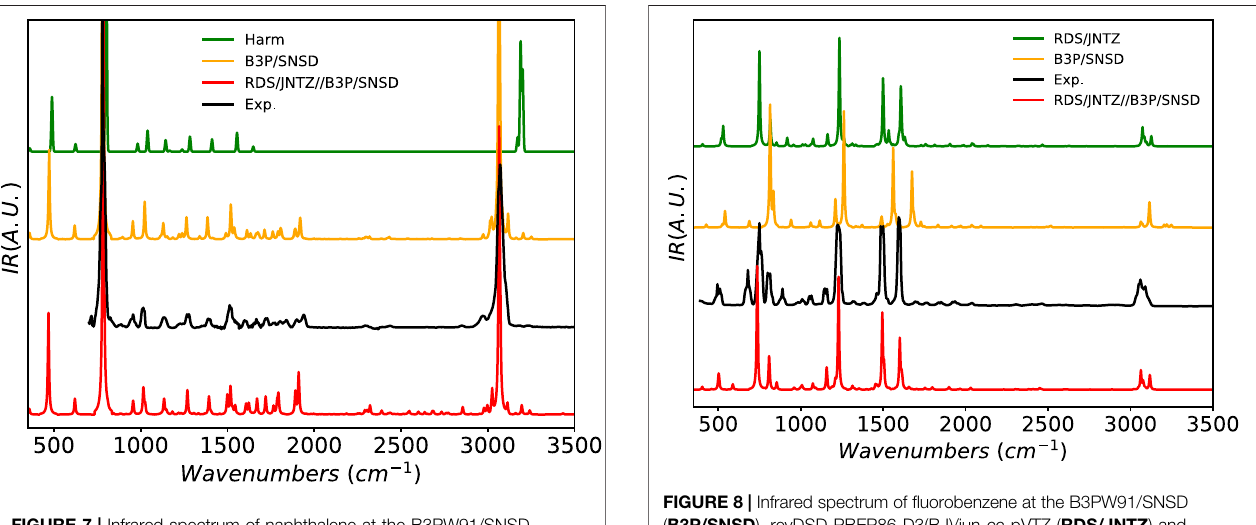
FIGURE 7 | Infrared spectrum of naphthalene at the B3PW91/SNSD ( B3P/SNSD ), revDSD-PBEP86-D3(BJ)/jun-cc-pVTZ//B3PW91/SNSD levels usingtheGVPT2scheme,comparedtoexperimenttakenfrom(Hudginsetal., 1994; NIST Mass Spec Data Center and Stein, 2015). The harmonic level was taken at the revDSD-PBEP86-D3(BJ)/jun-cc-pVTZ level, which serves as basis for the hybrid model. Theoretical line-shapes were broadened by mean of Lorentzian distribution functions with half-widths at half-maximum of 4 cm − 1